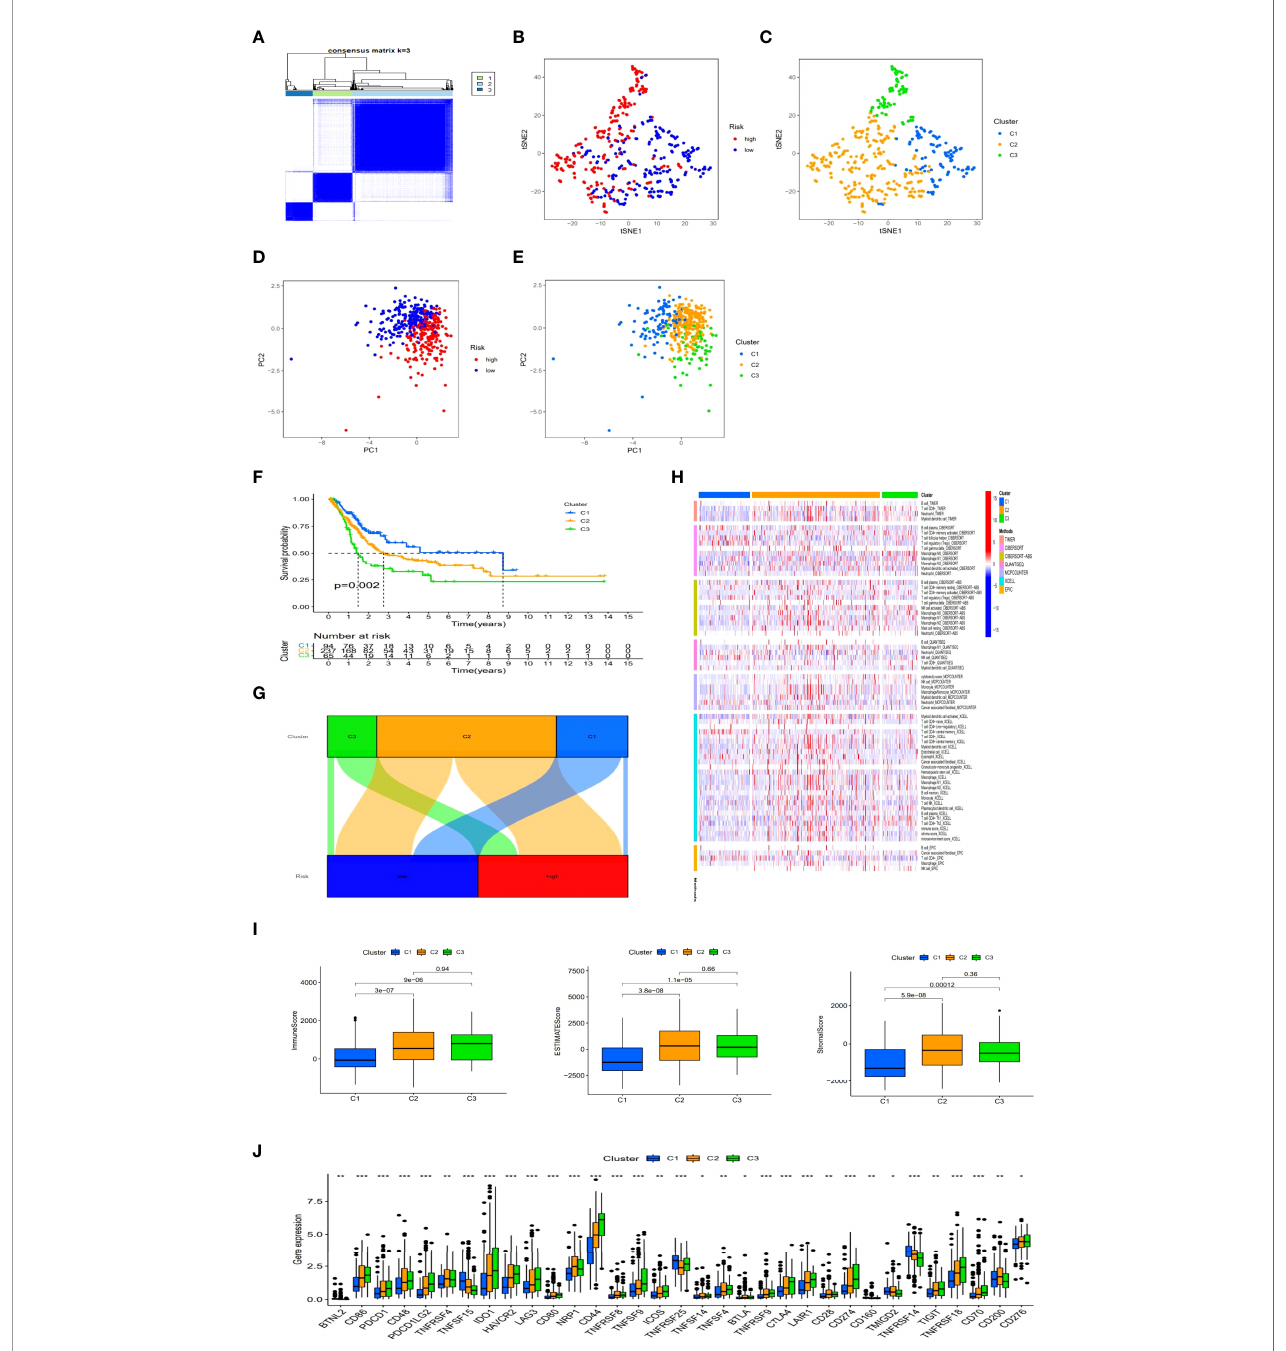
FIGURE 9 | Immunotherapy prediction and differences between cold and hot tumors. Patients regrouped three clusters via ConsensusClusterPlus (A) . The t-SNE of three clusters and risk groups (B, C) . The PCA of risk groups and clusters (D, E) . Clustered Kaplan – Meier survival curves for OS (F) . The connection between risk groups and clusters (G) . Clusters of immunological cells on a heat map (H) . Comparison of immune-related scores among three clusters (I) . The distinction of 32 immune checkpoints expression in clusters (J) . (*: p < 0.05, **: p < 0.01, and ***: p <